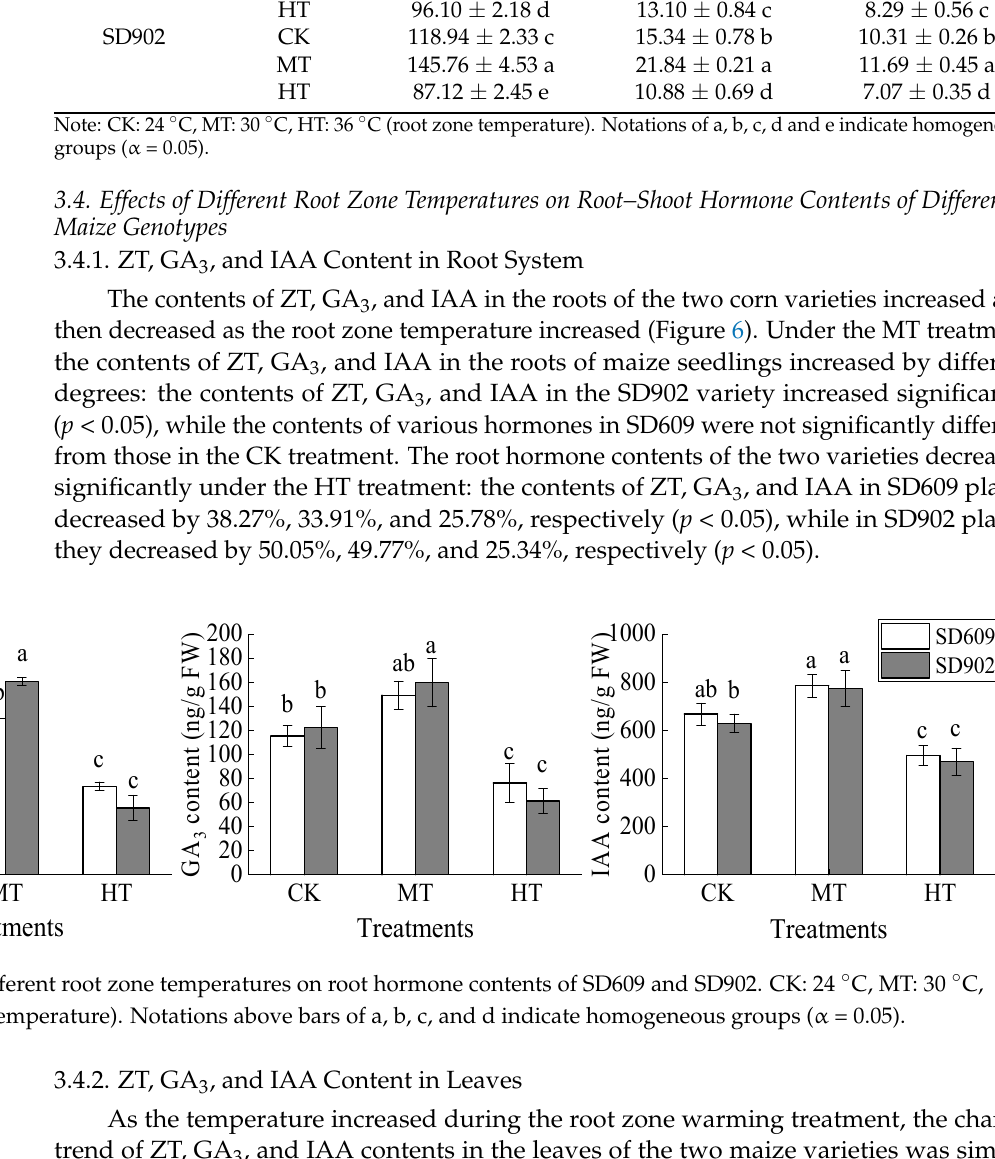
Table 2. Effects of different root zone temperatures on the leaf microstructure of SD609 and SD902. Figure 5. Effects of different root zone temperatures on the leaf microstructure of SD609 and SD902. ( A ) SD609 CK, ( B ) SD609 MT, ( C ) SD609 HT, ( D ) SD902 CK, ( E ) SD902 MT, ( F ) SD902HT. CK: 24 °C, MT: 30 °C, HT: 36 °C (root zone temperature). EC—epidermis cell, MC—mesophyll